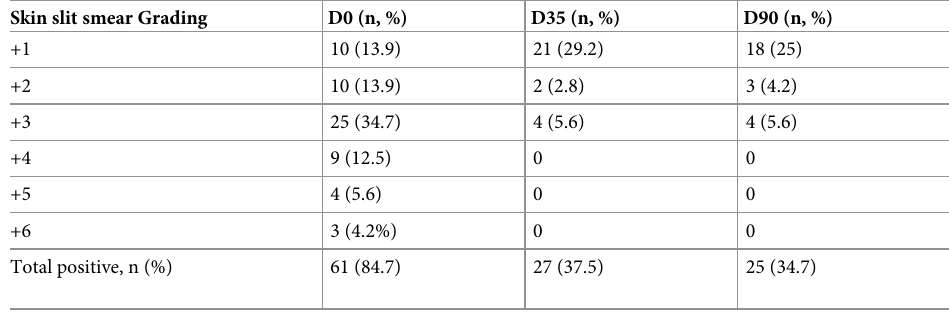
Table 2. Skin slit smear test result grading for localized cutaneous leishmaniasis patients, Boru Meda general Hospital, 2021.